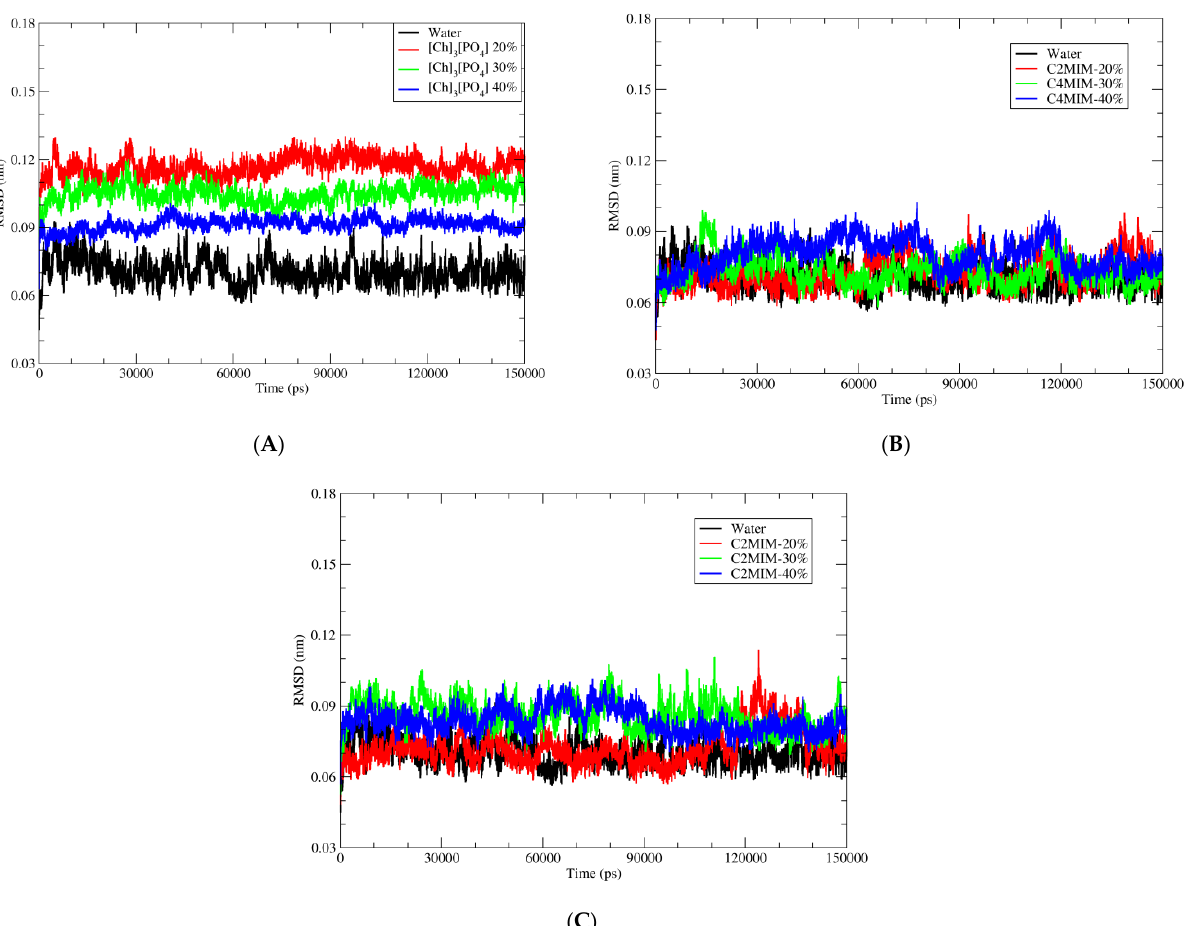
Figure 3. Root mean square deviation (RMSD) of C α atoms of wild type of PETase with water and three different ionic liquids solutions. ( A ) Pure water in black; 20% of [Ch] 3 [PO 4 ] in red; 30% of [Ch] 3 [PO 4 ] in green and 40% of [Ch] 3 [PO 4 ] in blue. ( B ) Pure water in black; 20% of [C4MIM][Ac] in red; 30% of [C4MIM][Ac] in green and 40% of [C4MIM][Ac] in blue. ( C ) Pure water in black; 20% of [C2MIM][Ac] in red; 30% of [C2MIM][Ac] in green and 40% of [C2MIM][Ac] in blue.